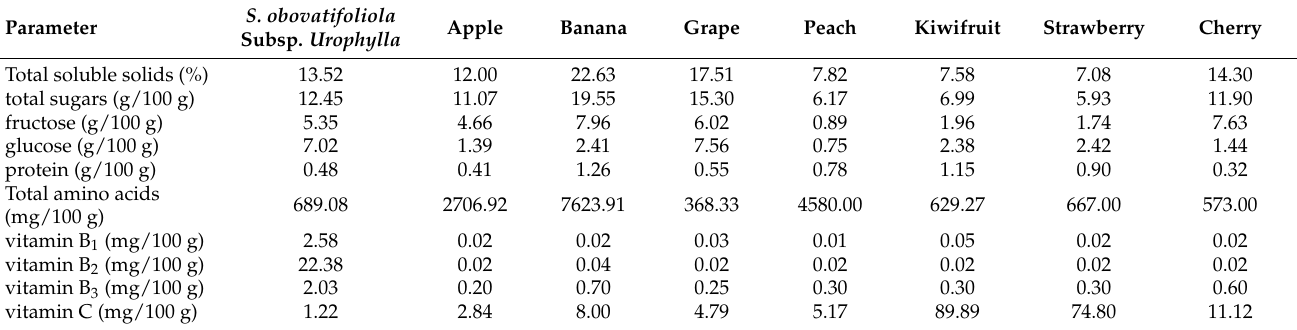
Table 5. The nutrient composition of S. obovatifoliola subsp. urophylla fruit at the ripening stage [54,55].